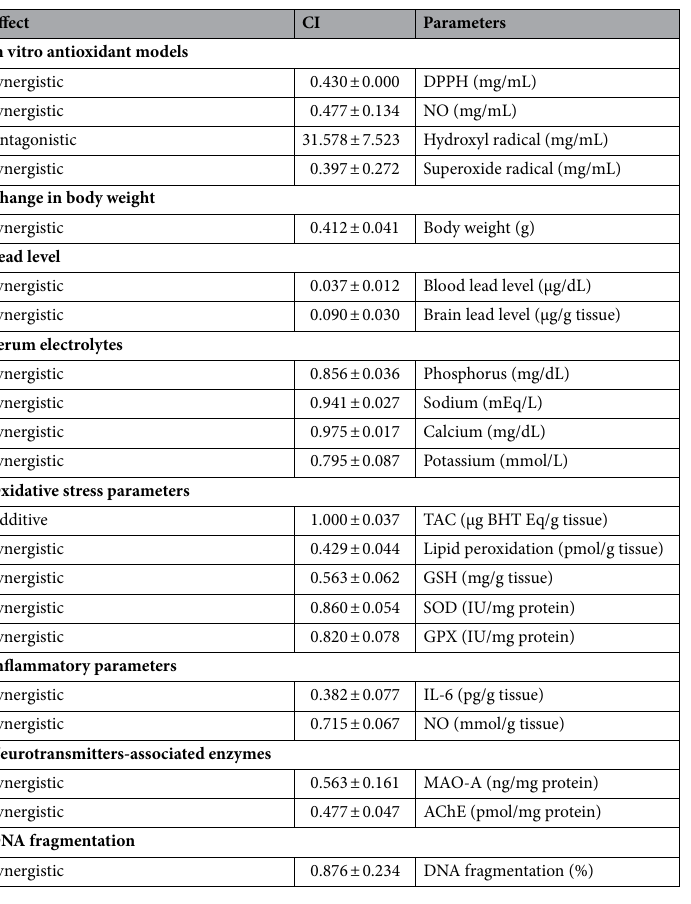
Table 3. The Combination index (CI) # values for the studied parameters on the mixture of Beta vulgaris juice (BVJ) and meso-2,3-dimercaptosuccinic acid (DMSA). # CI value of < 1 shows synergistic effect; > 1 shows antagonistic effect; = 1 shows additive effect. TAC total antioxidant capacity, DPPH α, α-diphenyl-β- picrylhydrazyl, NO nitric oxide, GSH Reduced Glutathione, SOD superoxide dismutase, GPX glutathione peroxidase, IL-6 Interleukin-6, MAO-A monoamine oxidase-A, AChE acetylcholine